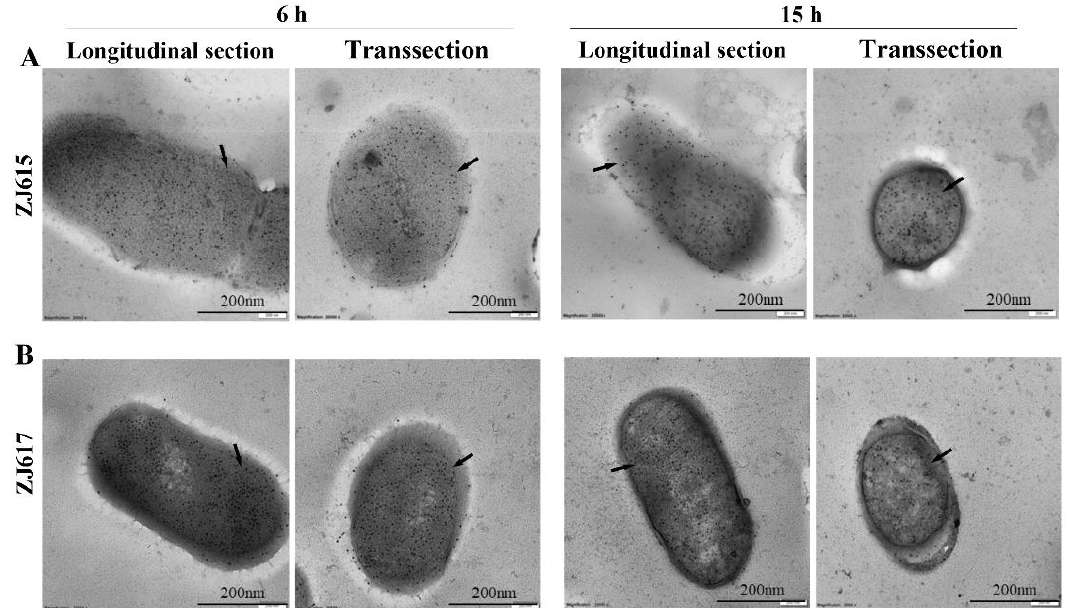
Figure 3. Immunoelectron microscopy analysis of GAPDH on the surface and in the cytoplasm of L. reuteri ZJ617 and ZJ615. GAPDH was visualized using an anti-GAPDH antibody and protein A-gold (10 nm-diameter particles) after bacteria were embedded and ultrathin sections were obtained. The black dots in the figure are labeled GAPDH protein, which is the position pointed by the arrow. ( A ) GAPDH in L. reuteri ZJ615 cultured for 6 h or 15 h. ( B ) GAPDH in L. reuteri ZJ617 cultured for 6 h or 15 h. Longitudinal (left) and trans-section (right) images are shown. Bars, 200 nm.